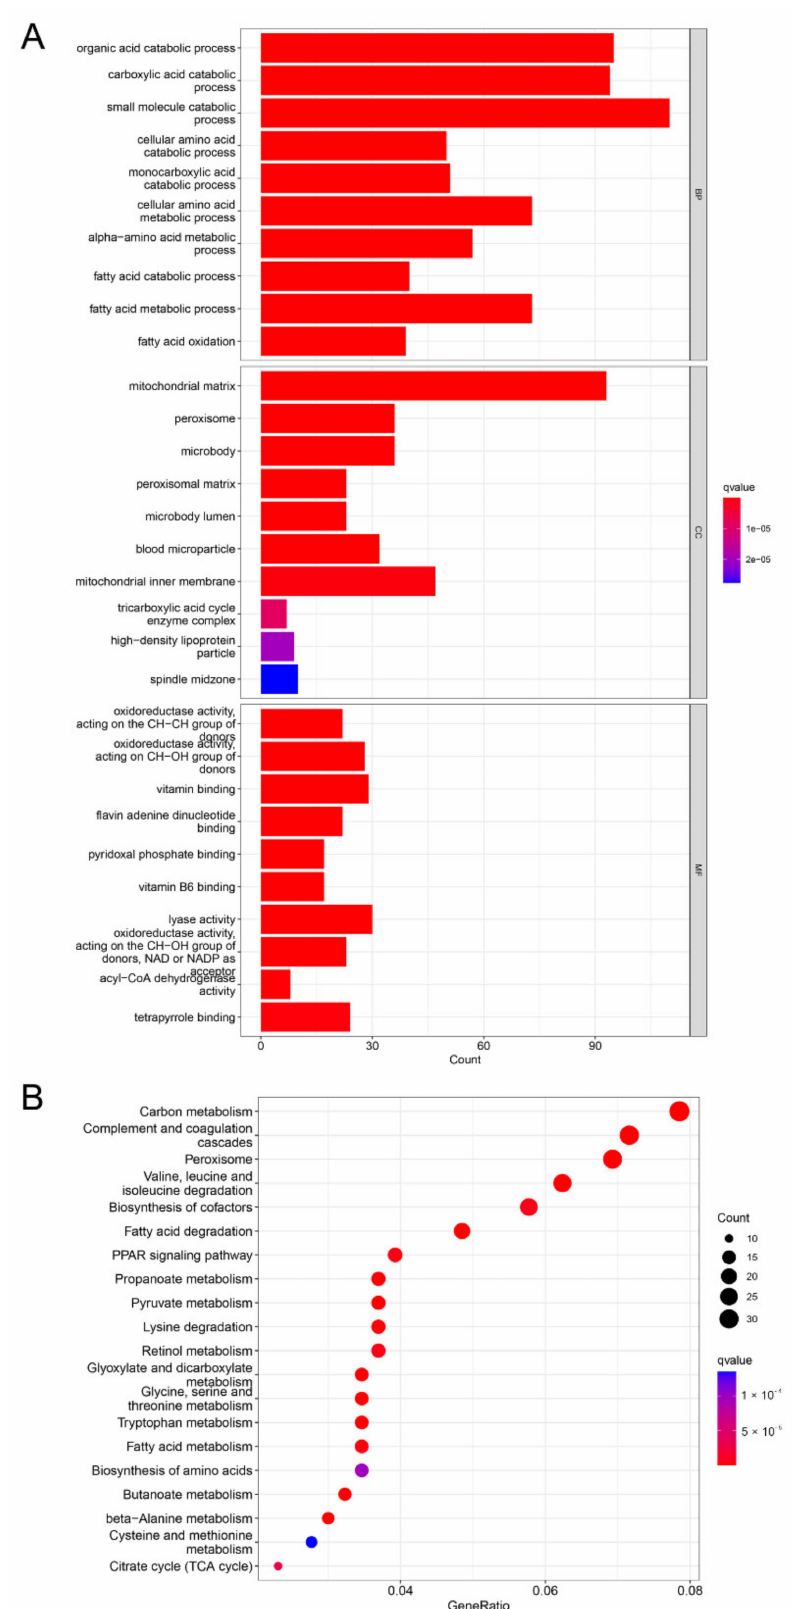
Figure 4. ( A ) KEGG pathway analysis of PROZ-associated genes. ( B ) GO analysis of PROZ- associated